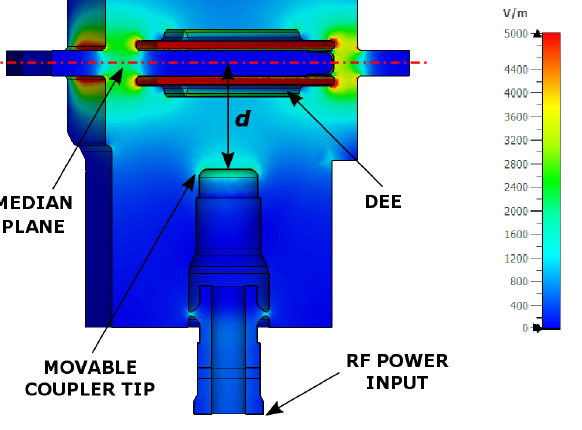
Figure 6. Vertical ( yz plane) cut showing the electric field intensity in the proximity of the coupler used for RF injection. The distance d between the coupler tip and the median plane is indicated. Note: arbitrary electric field normalization has been